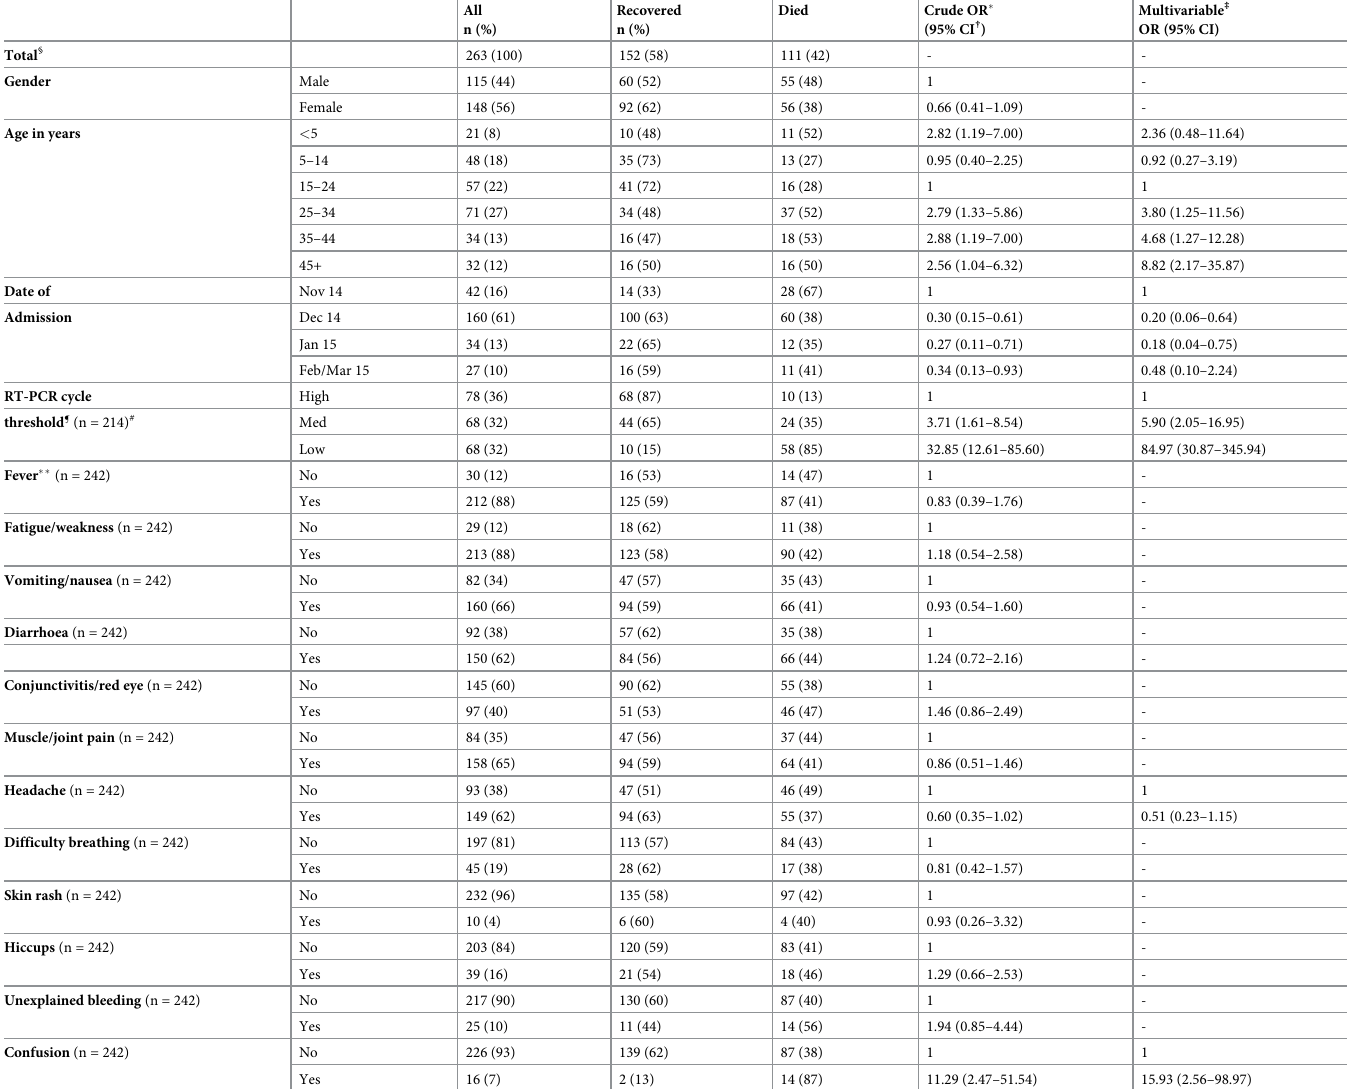
Table 1. Predictors for mortality amongst all EBOV-positive people admitted to Kerry Town